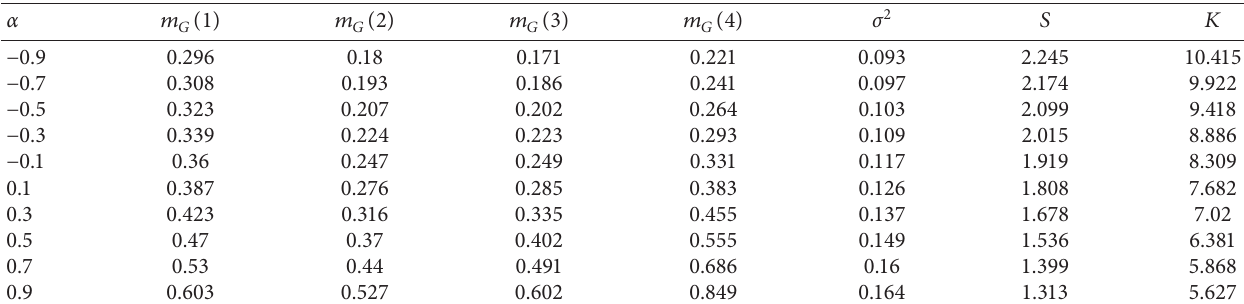
Table 3: Values of moment measures of the NTMW distribution for c � 0 . 5 and k � 1 . 2 and different values for α . α m G ( 1 ) m G ( 2 ) m G ( 3 )